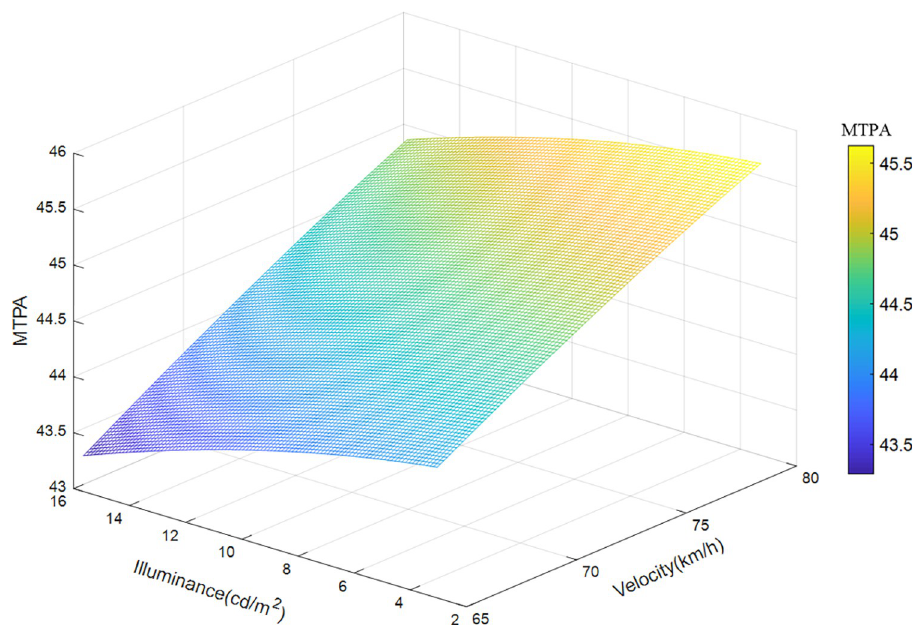
Fig 10. Variation characteristics of velocity, illuminance, and visual load in exit section.